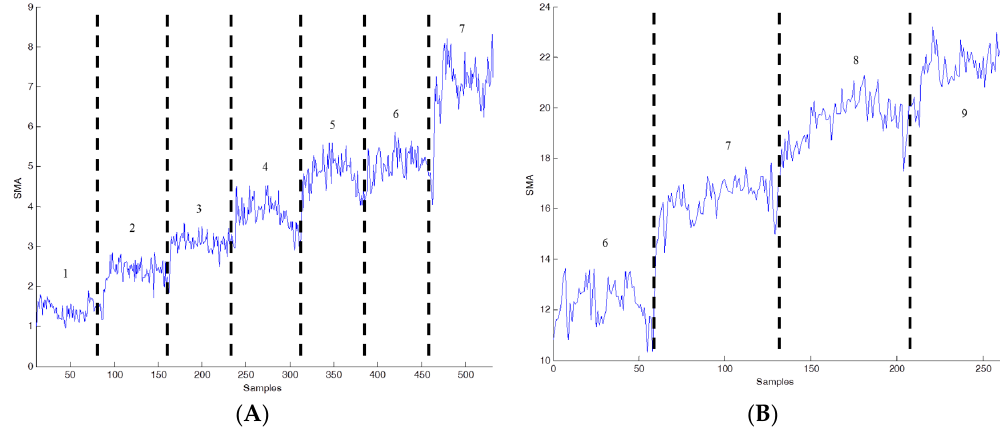
Figure 6. Different velocities with different SMA values. ( A ) SMA values during walking on the treadmill at velocities from 1 to 7 km/h; ( B ) SMA values during running on the treadmill at velocities from 6 to 9 km/h.